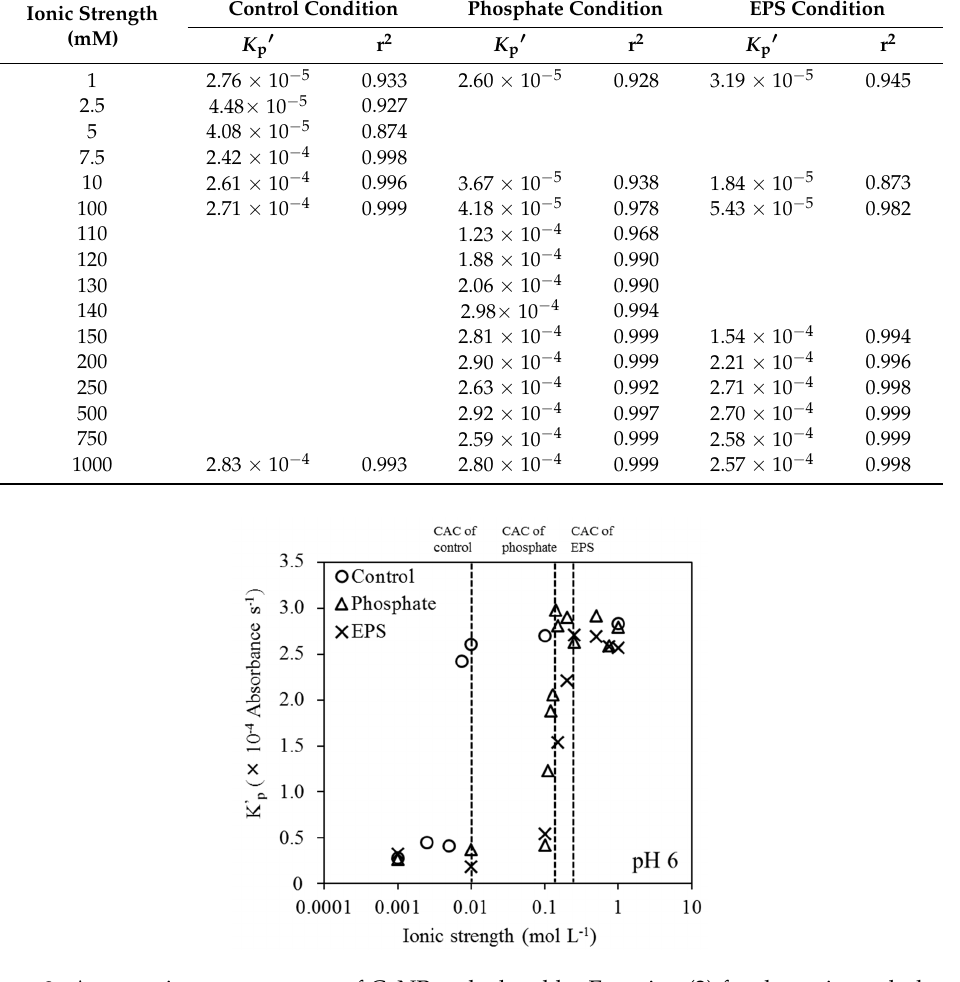
Figure 9. Aggregation rate constant of CeNPs calculated by Equation (2) for the reciprocal plot of absorbance in three different condition suspending 100 mg L − 1 CeNPs; control condition (circle), (B) phosphate condition (triangle), and EPS condition (cross).